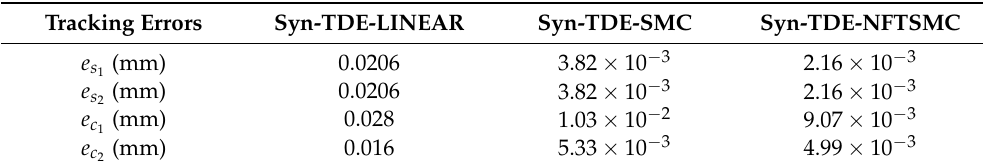
Table 5. The absolute average estimation errors (AAEE) of the Syn-TDE-NFTSMC computed